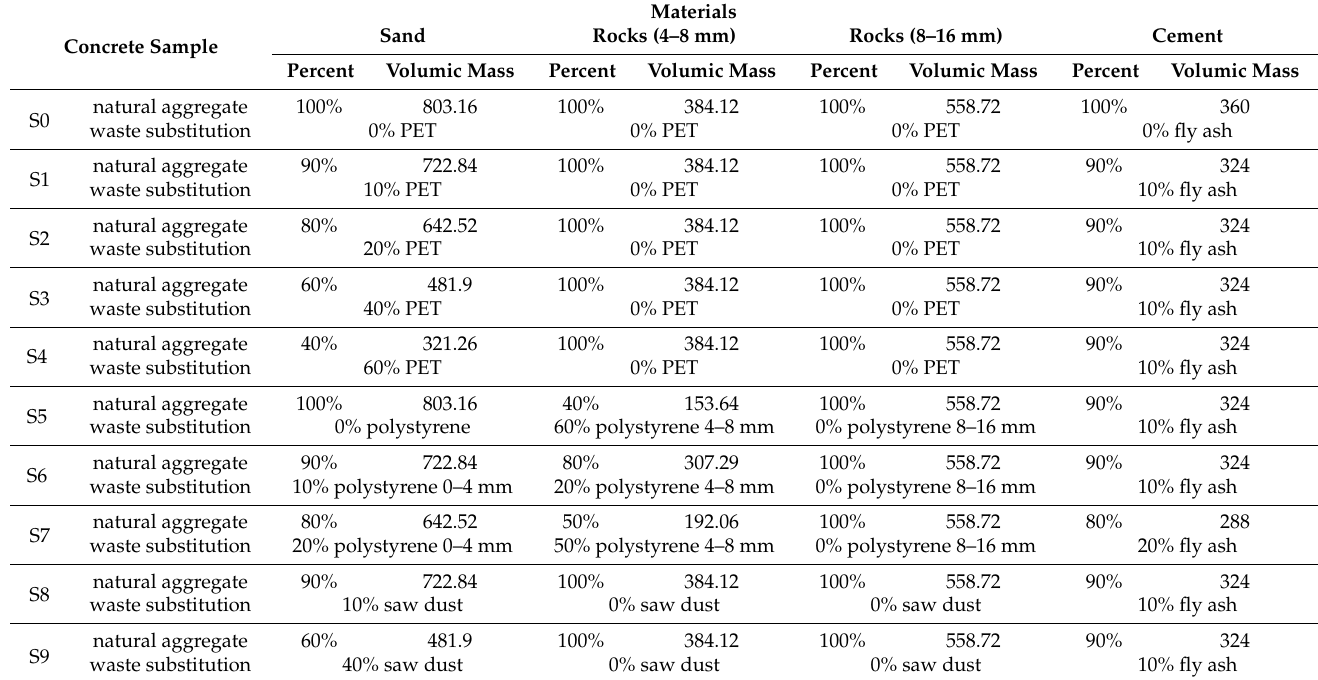
Table 2. Concrete mixture with waste